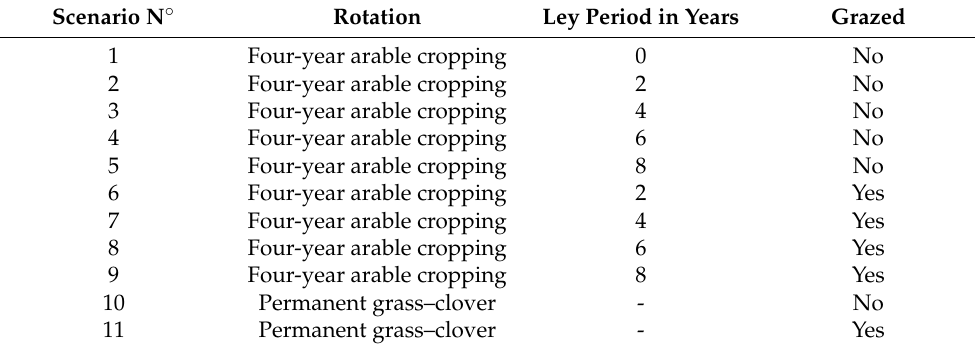
Table 1. Hypothetical long-term scenarios run to solely capture the effects of the implementation of alternative management practices (grazing regimes, length of grass–clover ley periods in crop rotations) in the conventional and organic agricultural